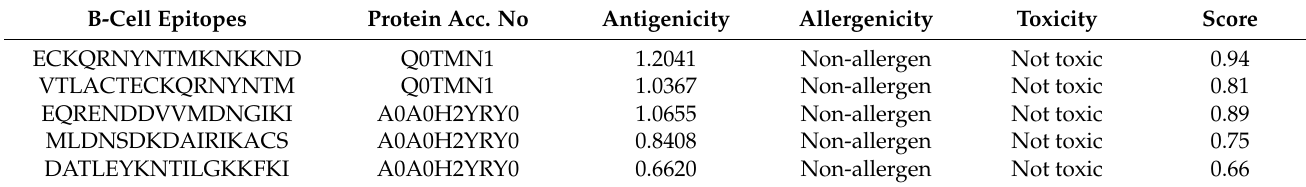
Table 3. B-cell epitopes for